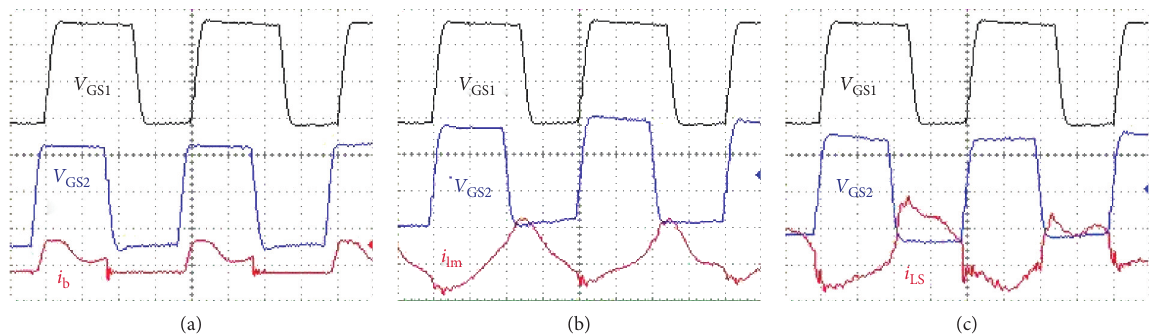
Figure 14: DISO mode results (scale: 5V/DIV, 2A/DIV, and 2.5 us/DIV). (a) Gate signals V (b) Gate signals V